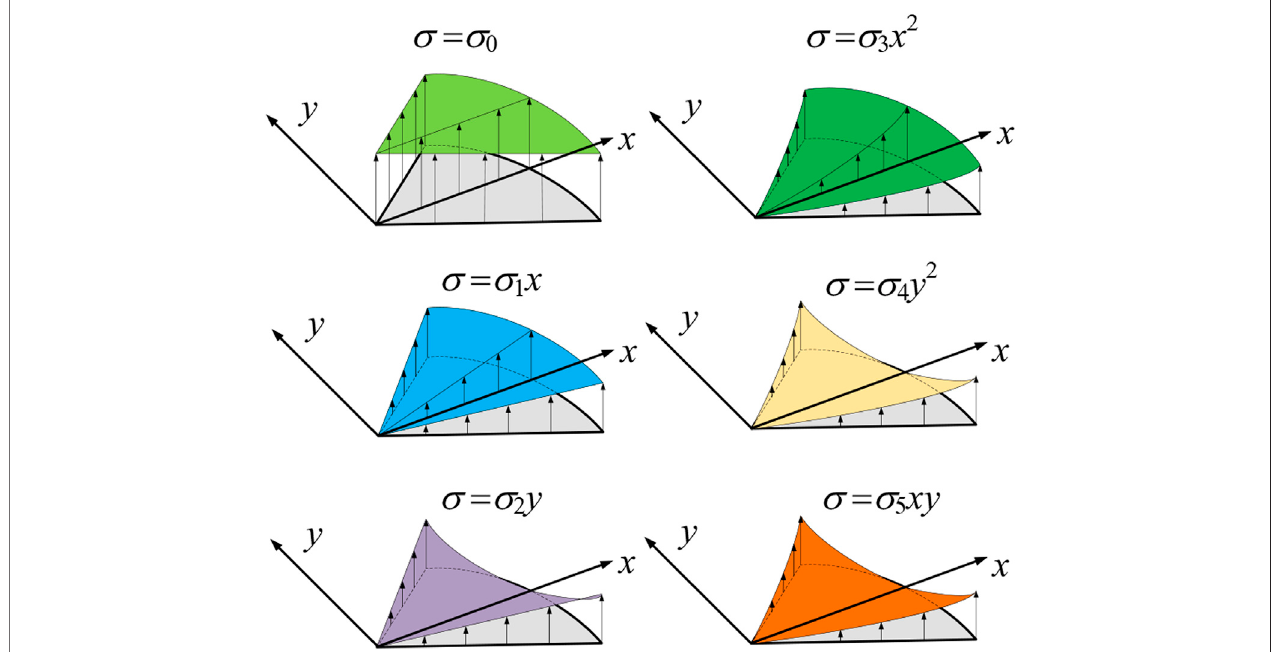
FIGURE 4 | Unit loading mode on the crack surface.